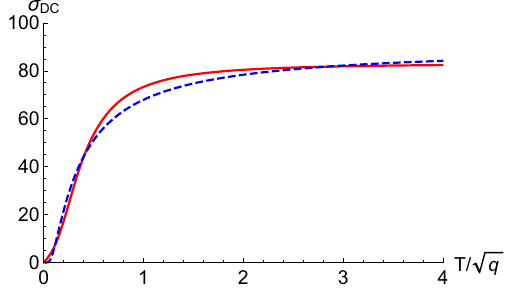
T/ q 0 1 2 3 4 Fig. 2 Red solid line is the result of holographic theory without the zero temperature conductivity contribution obtained from (17) and γ is atthecriticalvalue1 / 3.Bluedashedlineistheresultobtainedfrom(19). We have fixed k = 1 / 2 here. Coefficients A = 15 . 7127 , B = 3 . 48369, and C = 0 .